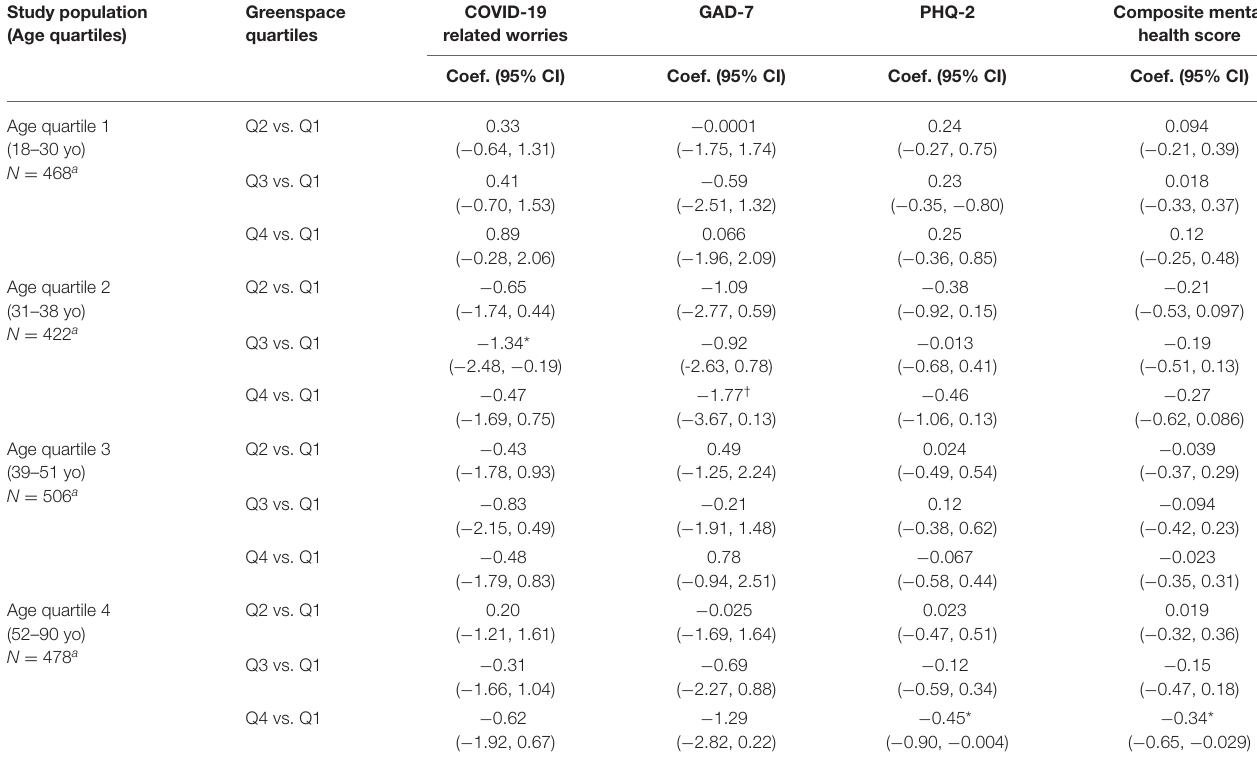
TABLE 3 | Greenspace and COVID-19-related worries, anxiety, depression, and composite mental health age stratification, multivariate regression analysis with multilevel models. Study population (Age